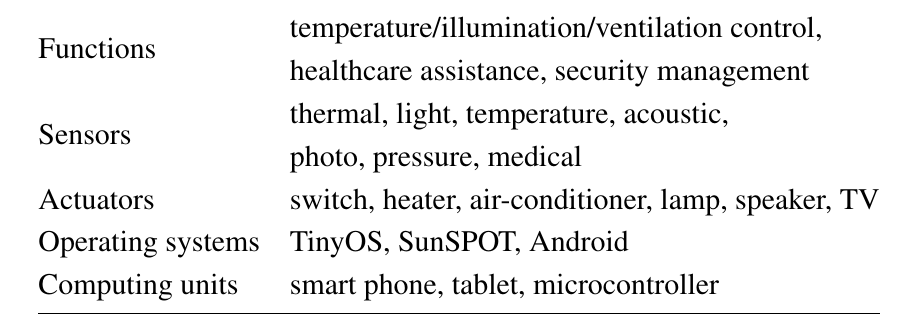
Table 1. The functions and devices in smart house